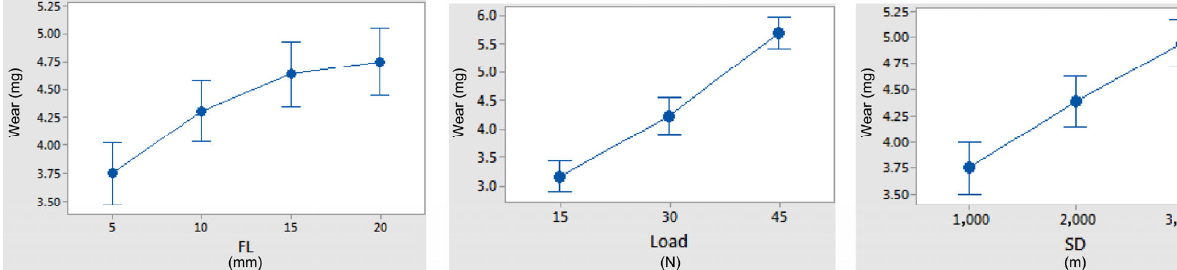
Fig. 3 Main effects plot for